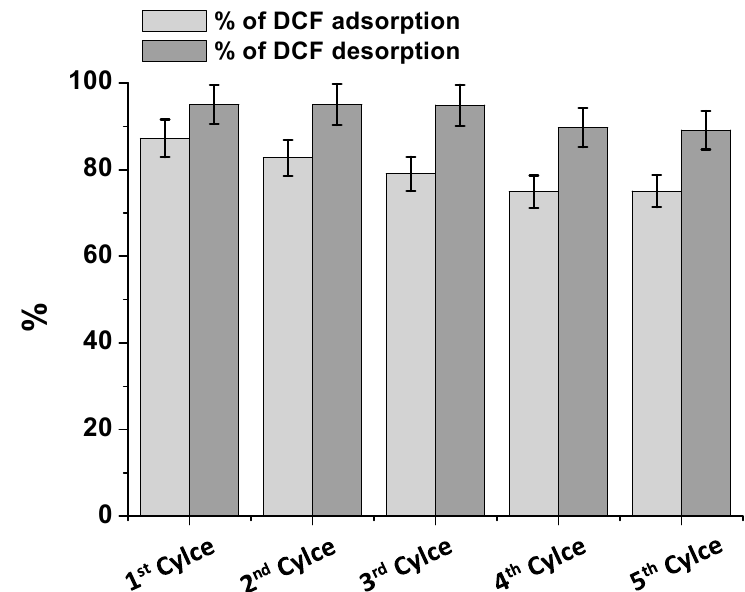
Figure 7. Percentage of DCF adsorption/desorption (in 0.25 M NaCl) on/from CH for five cycles. The contact time for each cycle was 120 min.